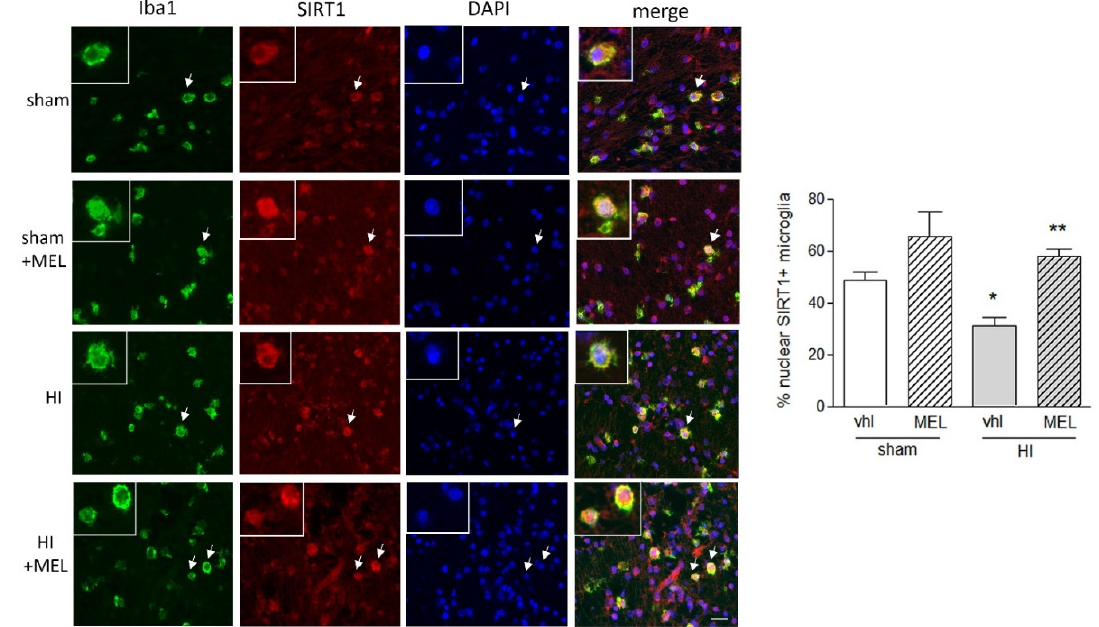
Figure 9. Melatonin promotes nuclear SIRT1 localization in amoeboid microglia of the corpus callosum in rats subjected to CCAO. Seven-day-old rats were subjected to sham surgery or to ligation of the right carotid artery followed by hypoxia (HI). Melatonin (MEL)-treated groups were subsequently injected with melatonin (10 mg/kg) and sacrificed after 24 h. Double immunohistochemical staining of Iba1 (green) and SIRT1 (red) with DAPI nuclear counterstaining (blue) is shown. The graph reports the percentage of nuclear SIRT1+, Iba1+ microglial cells in the area. Representative images of ipsilateral CC are shown. Insets show magnification of cells indicated by the arrows. Scale bar = 50 μ m. Bars are mean ± SEM of at least three animals/group. * p < 0.05 vs. sham and ** p < 0.05 vs. HI by one-way ANOVA followed by Newman–Keuls test for statistical